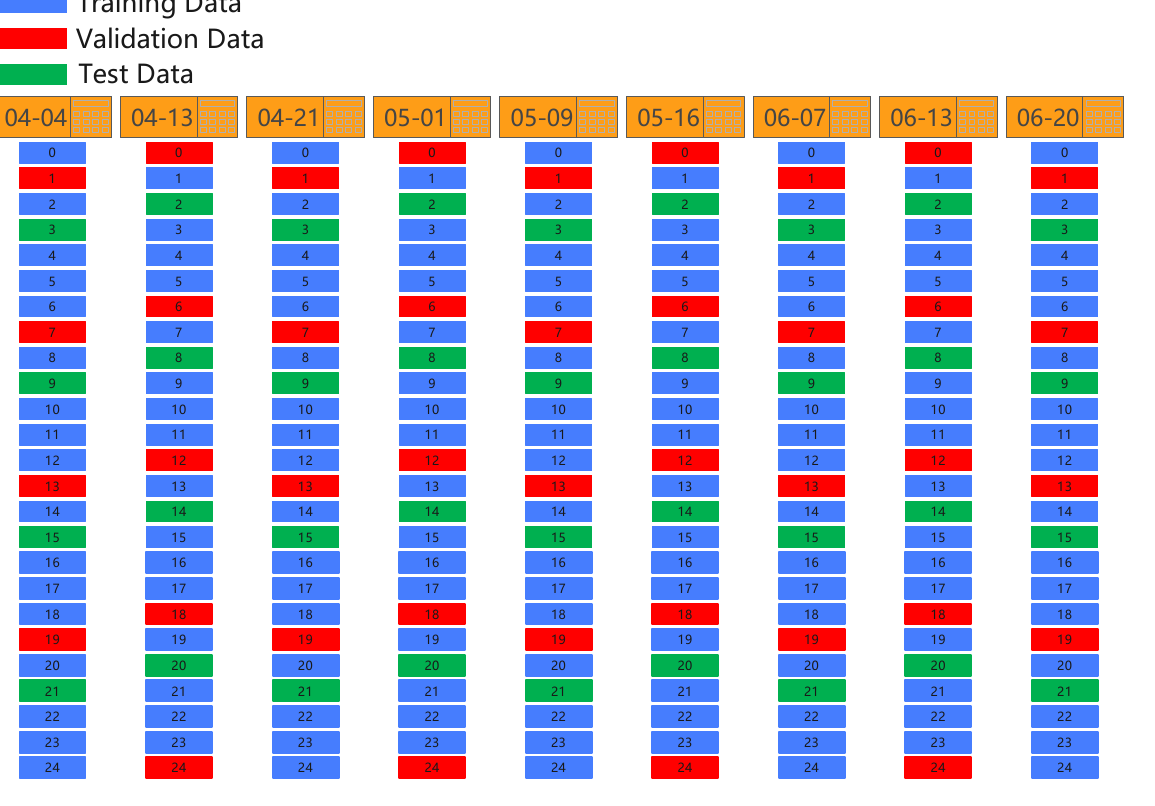
Figure 12. Division schematic diagram of dataset-3. It is divided based on location, and the locations used for the training, validation, and test set are